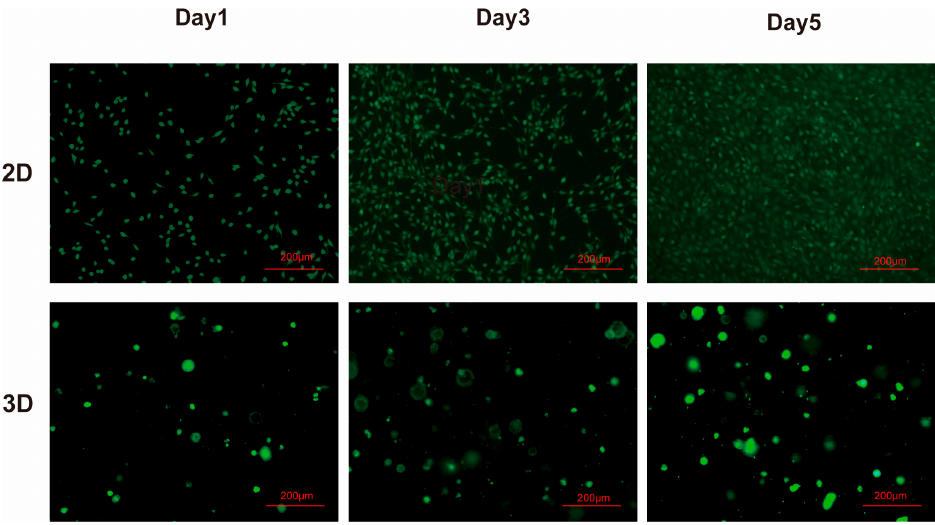
Figure 4. Cytotoxicity analysis of NIH3t3 in SCIBIOIII hydrogels. Calcein-AM staining analysis of NIH3t3 cells cultured in 2D and 3D on days 1, 3, and 5. Live cells are